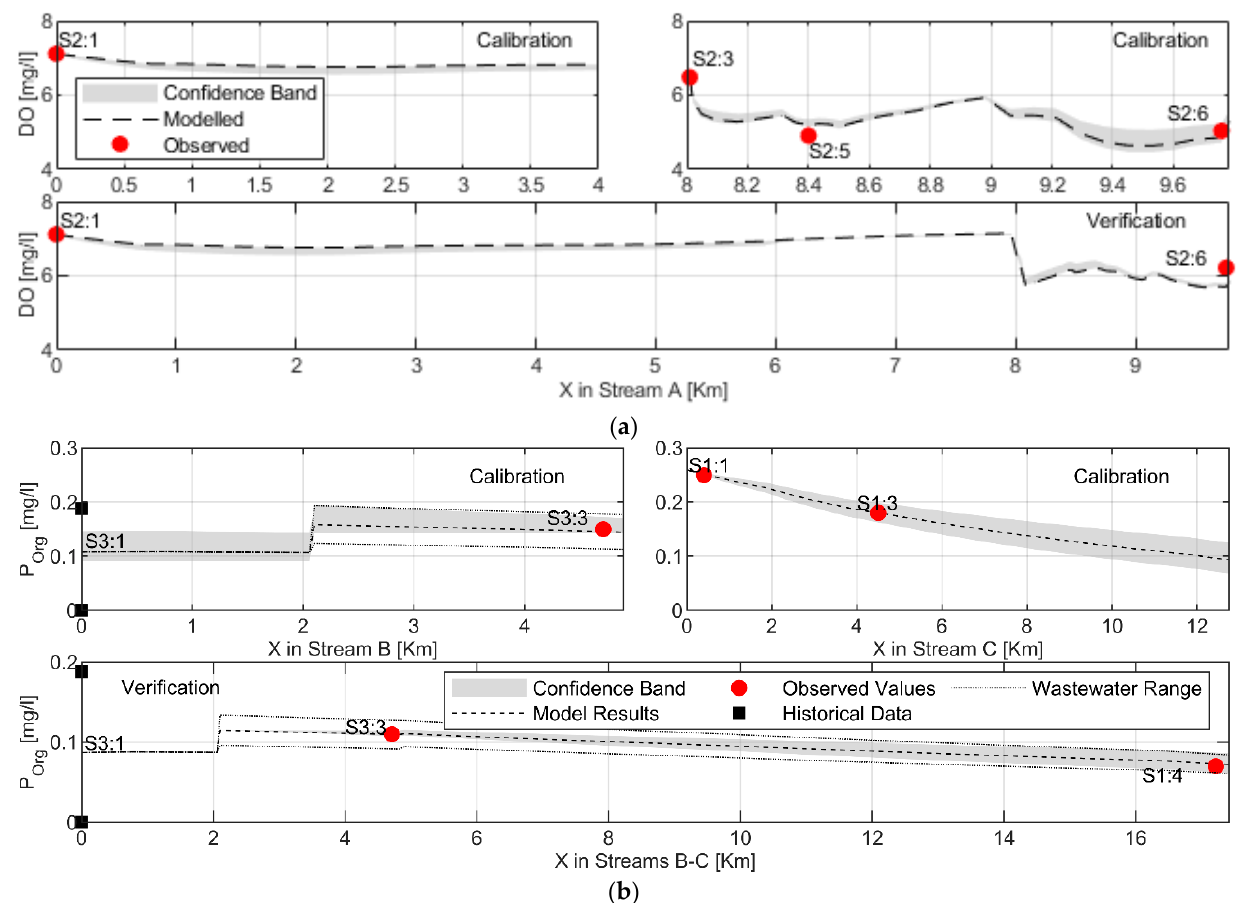
Figure 8. Model results and observations during calibration and verification: ( a ) dissolved oxygen in Stream A; ( b ) organic phosphorus in Streams B and C.